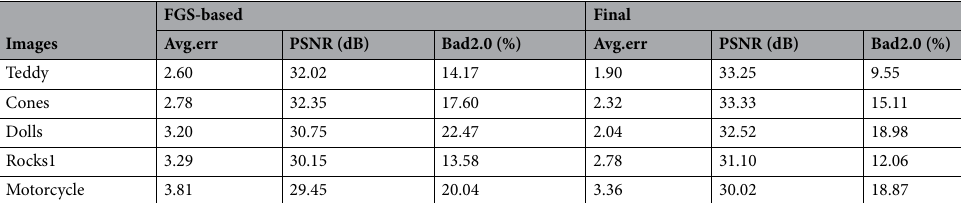
Table 4. Performance measures of the FGS algorithm for selected Middlebury stereo pairs after post- processing. Disparity estimates in the occluded regions were not excluded. FGS estimates significantly improved over the initial disparity estimates by all performance